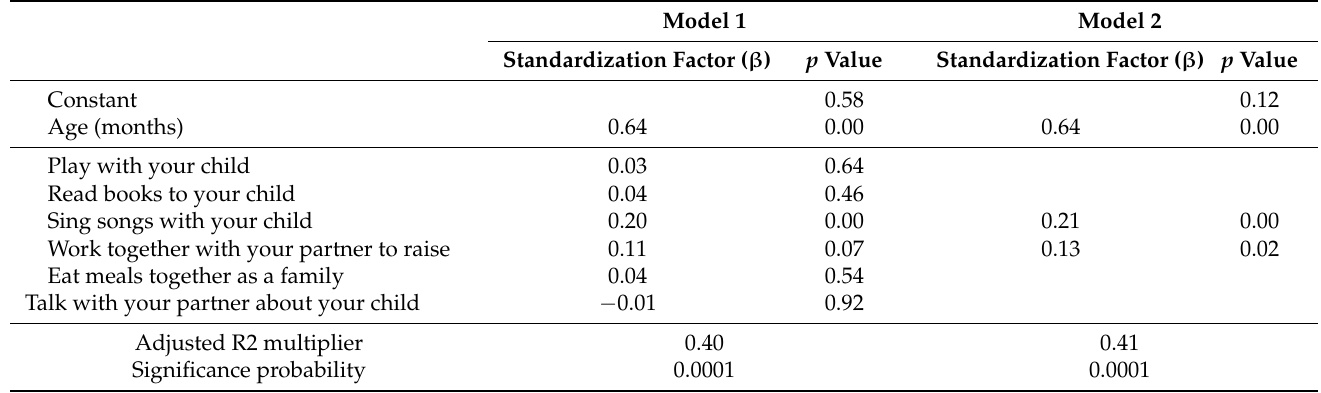
Table 3. Association between social development and parenting environment (multiple-linear